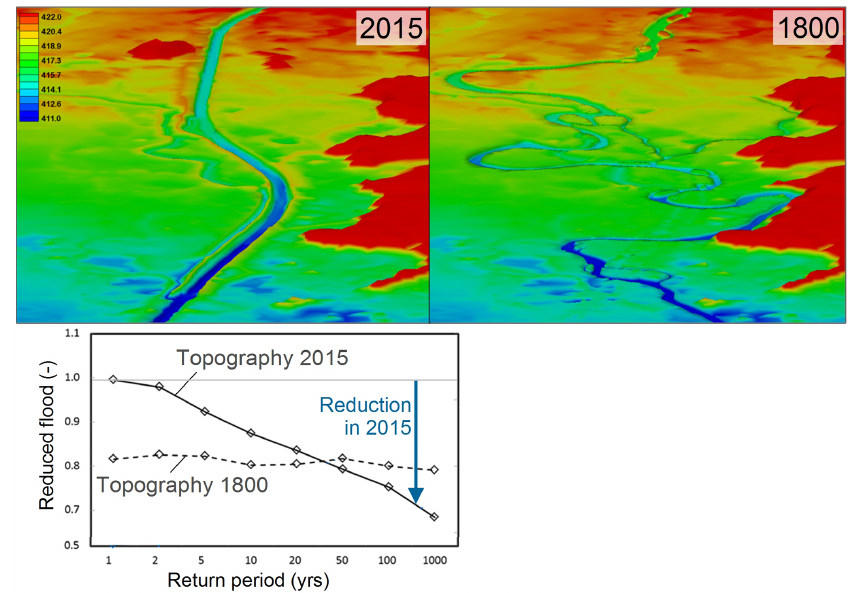
Figure 9. Effect of river training on peak runoff for a 70 km reach of the Bavarian Danube between Neu-Ulm and Donauwörth using a 2D hydrodynamic model. Top left: topography of the Danube and its flood plain in 2005, reflecting the straight channel due to river training. Top right: topography in 1800, reflecting the meandering morphology of the stream. Colours are elevation (m). Bottom: Flood peak attenuation within the 70km reach in terms of the downstream flood peak scaled by the upstream flood peak. The loss of storage volume in the flood plain between 2015 and 1800 mainly concerns small events. For example, for a return period of 1 year, the 1800 downstream peak is 82% of the upstream peak, while the 2015 downstream peak is identical with the upstream peak. For large events, the river training has little effect on peak runoff (Skublics et al.,